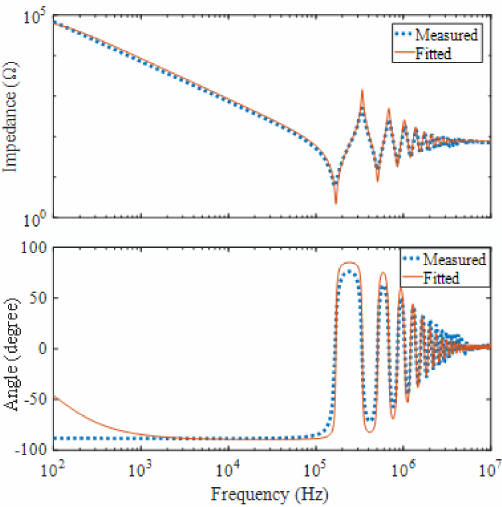
Figure 7. OC impedance of 200 m power cable in